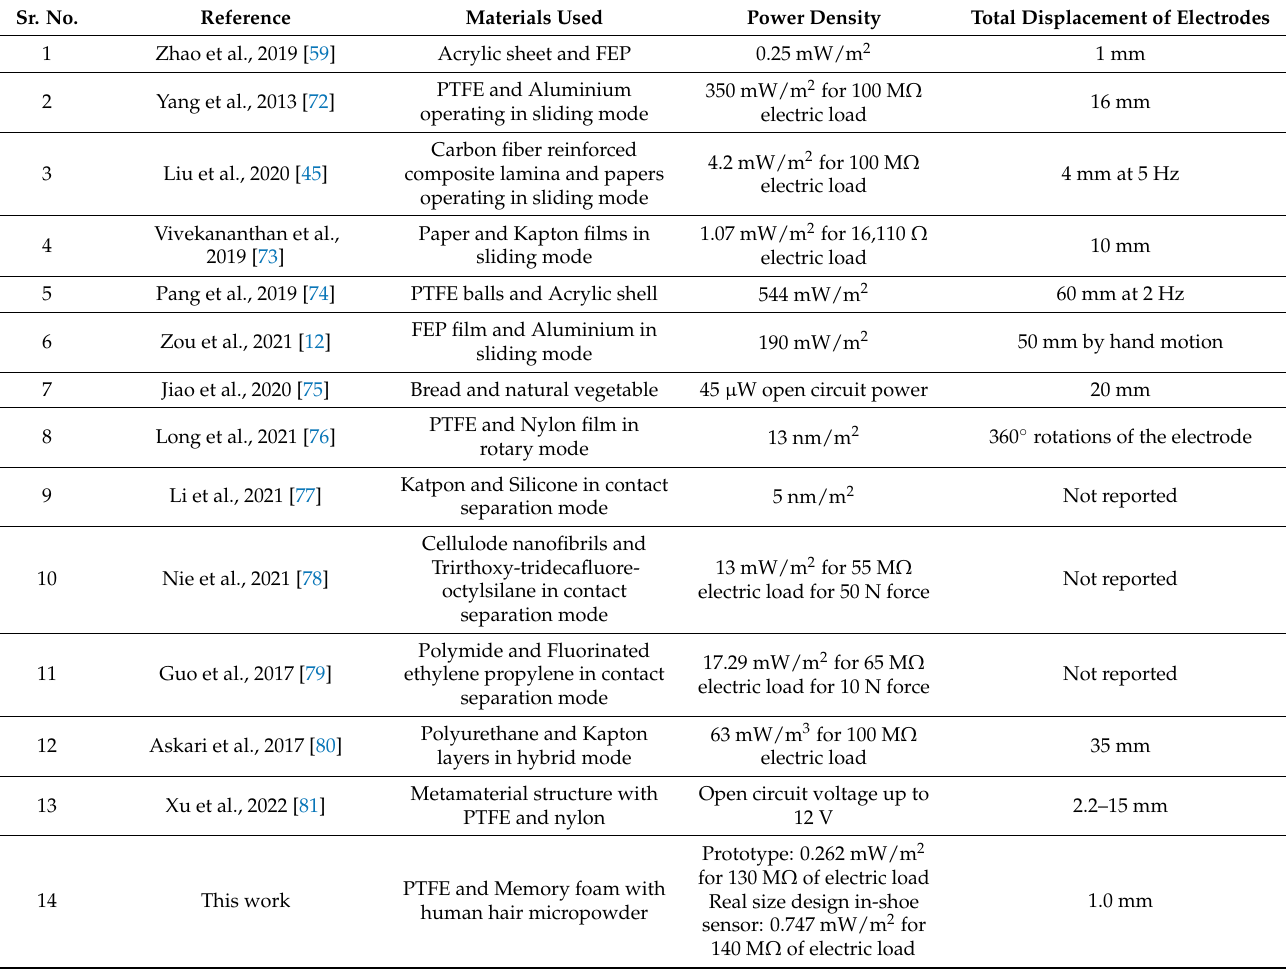
Table 3. Comparison with existing reported